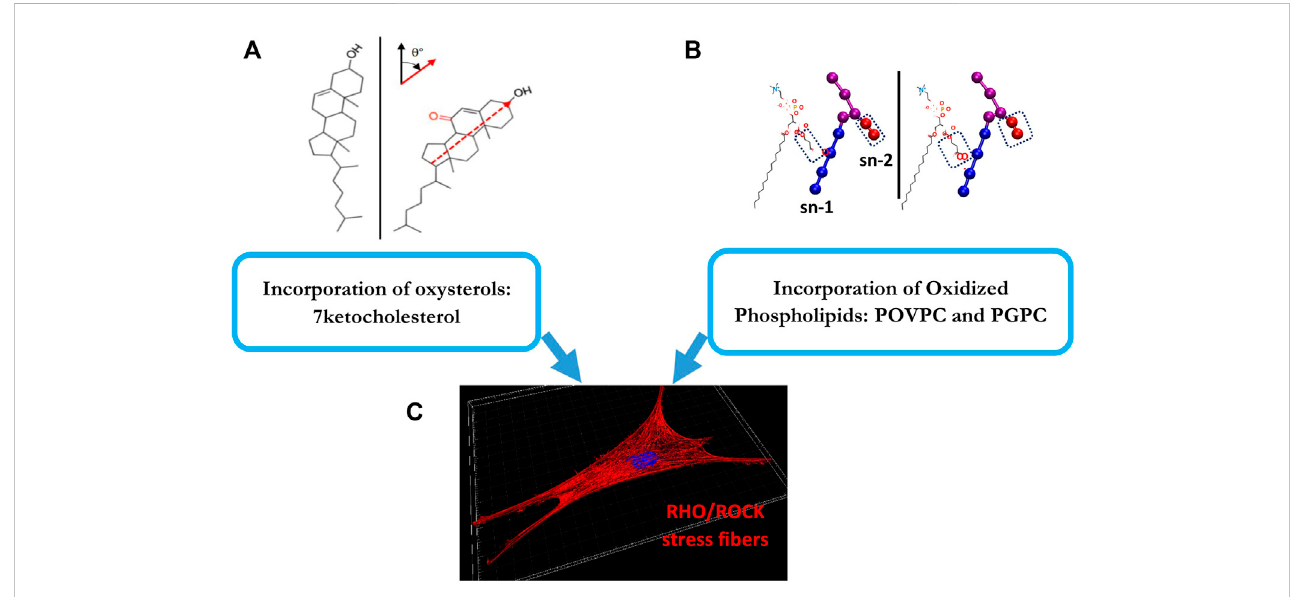
FIGURE 3 Oxidized lipids that induce endothelial stiffening: The top panels (A,B) show the structures of the major oxidized lipids that contribute to endothelial stiffening:a7-ketocholesterol(left)and oxidized phospholipids, POVPC andPGPC (right). (A) shows thestructures of cholesterol (left) and7-ketocholesterol, asevidentfromtheadditionalcarbonylgroup,(right)shownattheirorientation/tiltinthelipidmembrane[adoptedfromAyeeetal.,2021aspublishedin Front Cardiovasc Med 8 (Ayeeand Levitan, 2021)]. (B) shows thechemicalstructures and coarse-graintopologies ofoxidized lipid molecules POVPC (left)and PGPC (right) with polar headgroups and glycerol backbones shown as purple spheres, sn-1 tails as blue spheres and sn-2 truncated oxidized tails (circled) as redspheres[adoptedfromAyee etal.,2017aspublishedin BiophysJ 112(2)(Ayeeetal.,2017b)]. (C) showsendothelialstress fi bersthatareinducedasaresult of the incorporation of both types of these oxidized lipids into the plasma membrane via activation of RhoA/ROCK cascade. This is described in Section 4 of the